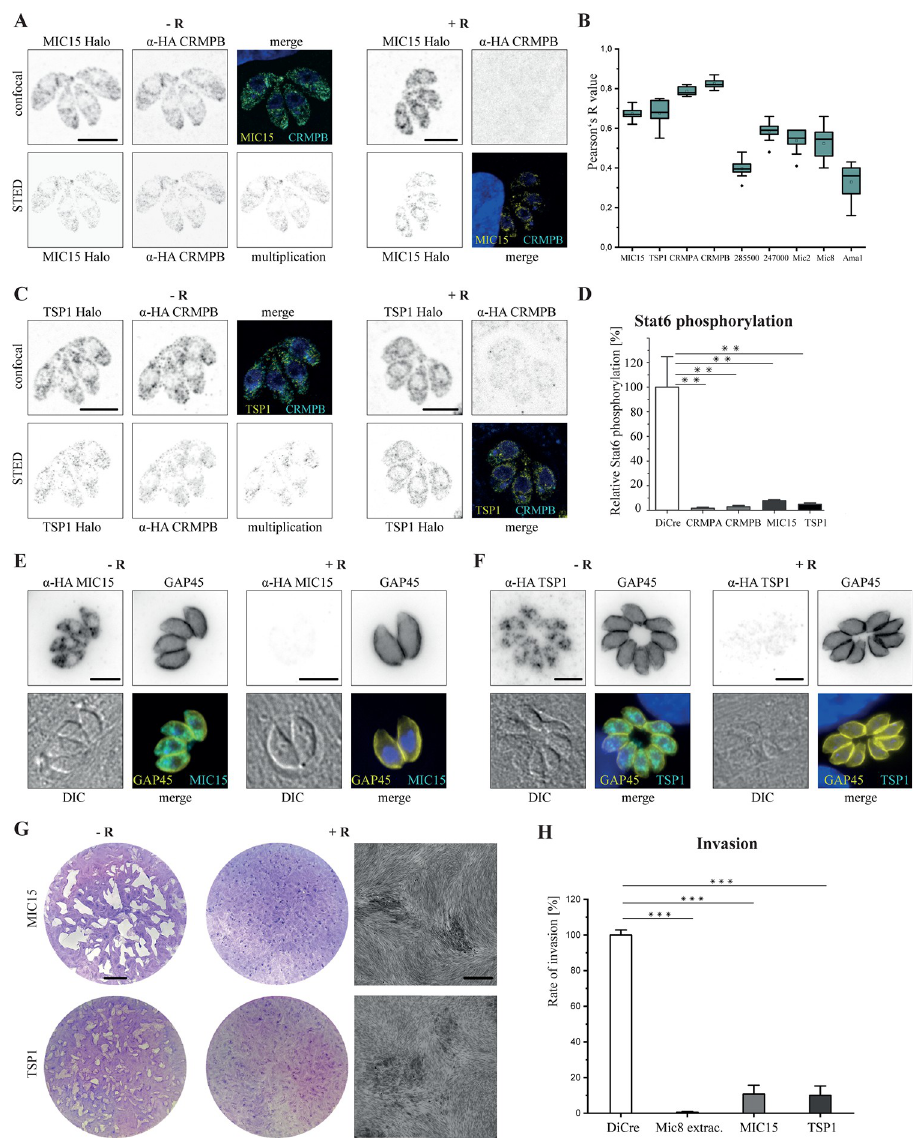
Fig 5. Localization of potential interaction partners. ( A) Localization of MIC15 and CRMPB (RH-CRMPB-HA floxed MIC15-Halo) labeled with α -HA Atto594 and Halo stained with Janelia Fluor 646. On the right localization, 72 h post- induction with rapamycin is shown. ( B) Box blot of colocalization analysis of proteins with CRMPB 3HA, CRMPB data point is colocalization of CRMPA-3HA with CRMPB-sYFP2. Intracellular parasites were stained with α -HA Alexa 488. MIC15 AU : Pleasecheckandconfirmthattheeditstothesentence } MIC 15 ; TSP 1 ; TGGT 1 2 85500 ; andTGGT 1 2 47000 werelabeledprefixation ::: } didnotaltertheintendedthoughtofthesentence : , TSP1, TGGT1_285500, and TGGT1_247000 were labeled prior to fixation with Janelia 646; CRMPA was labeled with α -GFP atto594; MIC2, MIC8, and AMA1 were labeled with respective antibodies and stained with Star635p. Single vacuoles of deconvolved stacks were analyzed in all planes with the color2 plugin, and the Pearson’s R value of 10 vacuoles is shown (box shows 25%–75%, median indicated by line, average by little white box, outliers black dots, error bars show standard deviation). ( C) Localization of TSP1 and CRMPB (RH-CRMPB-HA floxed TSP1-Halo) as in ( A) . ( D) Quantification of Stat6 phosphorylation by ROP16 as a measure of rhoptry secretion. Shown is relative Stat6 phosphorylation 72 h post-rapamycin induction from biological triplicates. ( E) Localization of MIC15 and Gap45 in RH-MIC15-3HA floxed induced + and − 96 h rapamycin. ( F) Localization of TSP1 and GAP45 in RH-TSP1-3HA floxed induced + and − 96 h rapamycin. ( G) Plaque assay of floxed MIC15 and TSP1. Scale bar of the entire plaque assay is 5 mm; scale bar of the higher-resolution area is 500 μ m. ( H) Invasion assay of RH-MIC15-3HA floxed and RH-TSP1-3HA floxed 72 h post-induction. All scale bars except ( G) are 5 μ m. Statistical analysis: two-tailed Student t test. ��� p < 0.001. See also S1 Data.